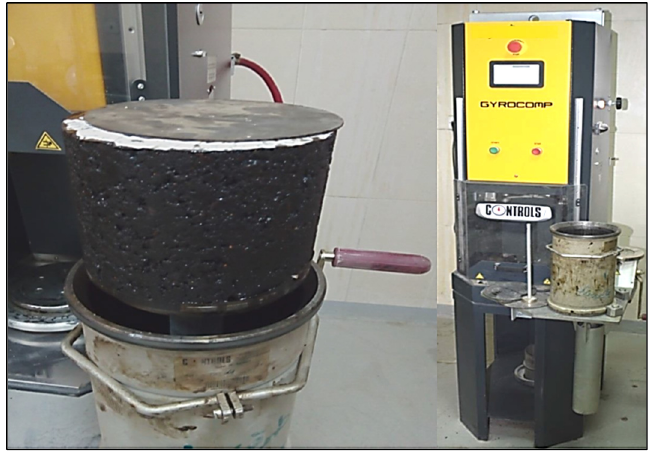
Figure 6. SGR apparatus.